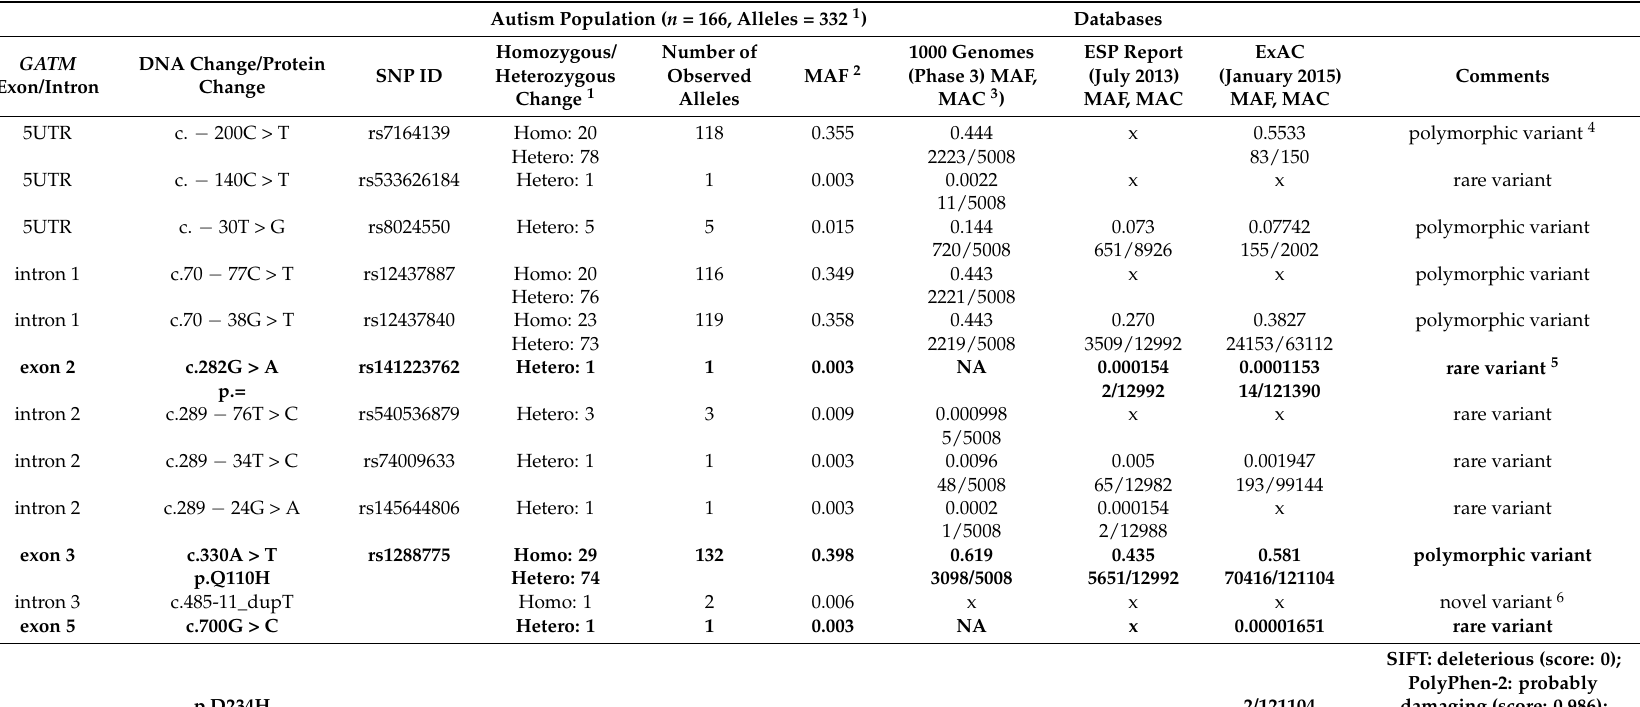
Table 1. Summary of GATM (glycine amidinotransferase) gene sequencing results. Variants identified in the autisim spectrum disorder (ASD) population are noted, and minor allele frequency (MAF) calculated. MAF of variants present in 1000 Genomes, Exome Sequencing Project (ESP) and Exome Aggregation Consortium (ExAC) databases are shown for comparison. 1 Total number of samples = 166 (332 alleles); 2 MAF = minor allele frequency; the number of alleles in which variant was found/total number of alleles; 3 MAC = minor allele count; the number of times the minor allele was observed in the sample population of chromosomes; 4 Polymorphic variant: (>0.01 MAF in one database); 5 Rare variant: ≤ 0.01 MAF in at least one published database; 6 Novel variant: Not present in any published database; coding sequence (exons) are in bold. SNP: single nucleotide polymorphism; UTR: untranslated region; and SIFT: ‘sorting tolerant from intolerant’